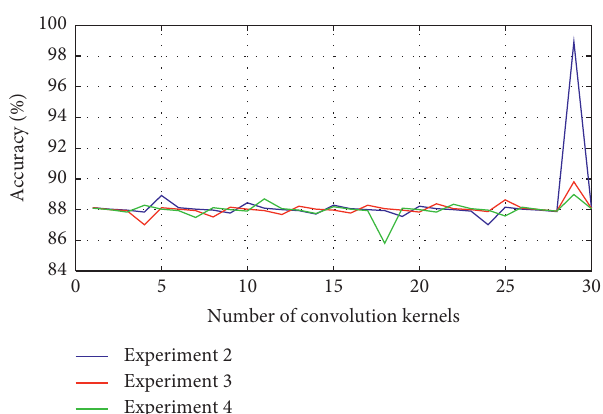
Figure 7: The relationship between the size of the convolution kernel and the recognition result.